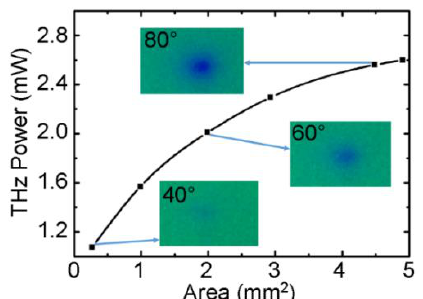
Figure 5. Relation between THz power and transient color change area when THz radiation is incident for 1 sec. The insets show the areas of color change under different THz powers.